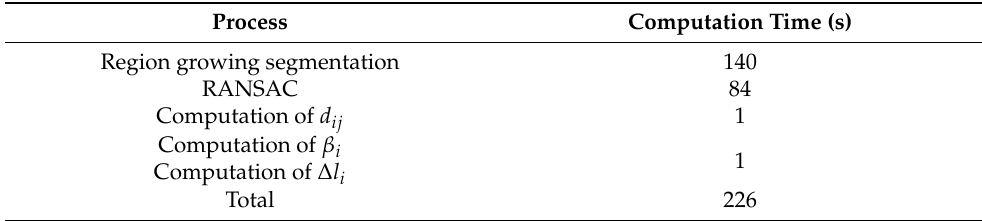
Table 9. The computation time of the data processing of